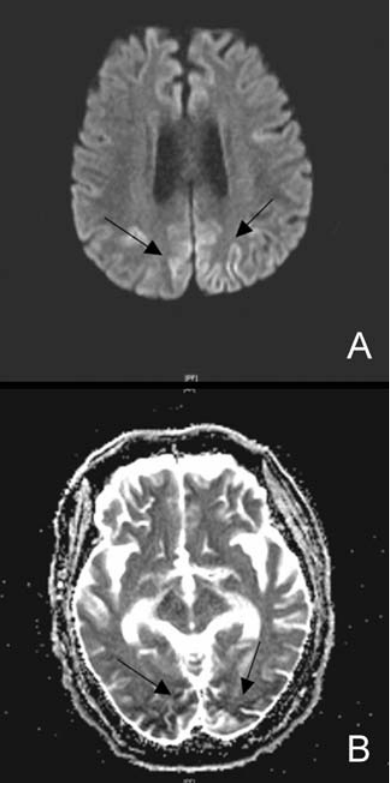
Figure 1. Brain magnetic resonance sequencing diffusion-weighted imaging (A) showed high signal intensities over bilateral occipital regions whereas in Apparent Diffusion Coefficient Mapping (B) showed decreased signals (black arrows).